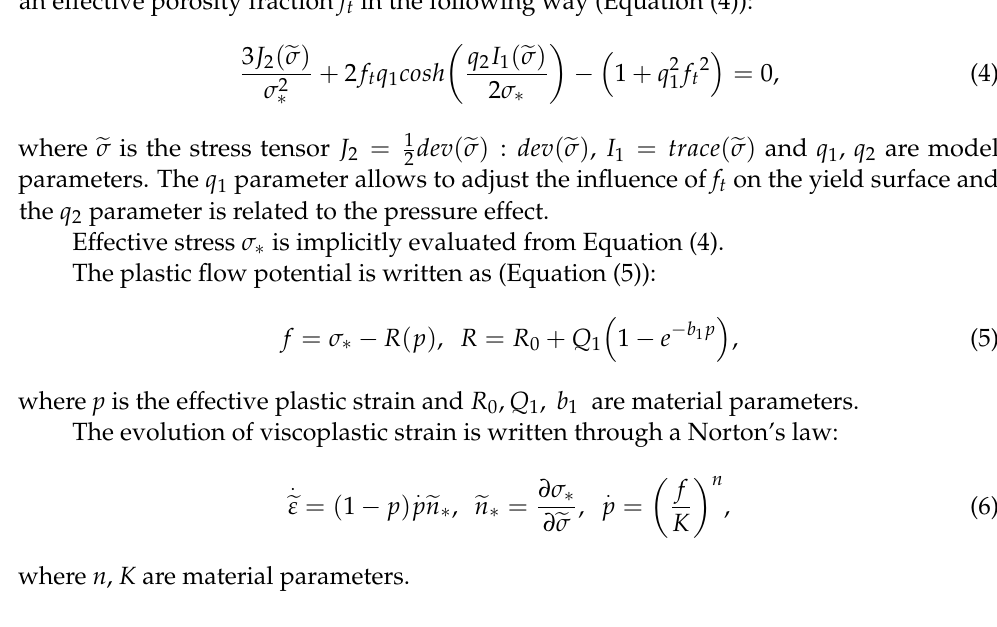
Figure 12. ABS cavitation independence toward strain speed—SEM pictures of post-mortem sam- ples.